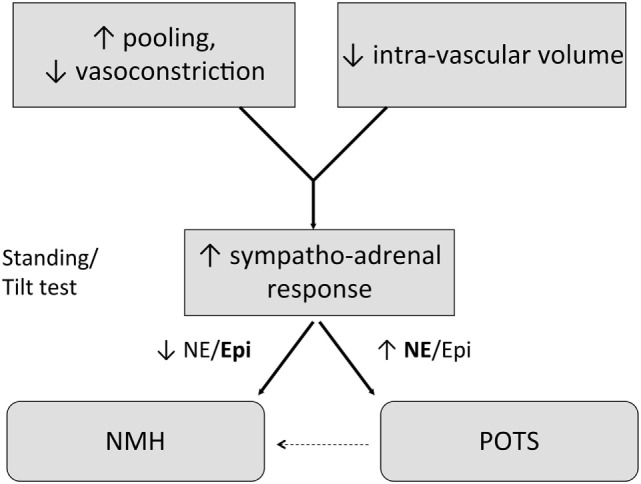
The three main pathophysiologic influences on orthostatic intolerance (OI) are shown in this Figure. Increased pooling of blood, or defective vasoconstriction in the lower half of the body, along with lower intravascular volume are each important, and can be present in the same individual. Upon assumption of an upright posture, exaggerated sympathetic nervous system and adrenal hormone responses lead to increased release of epinephrine (Epi) and norepinephrine (NE). It is postulated that the relative balance of NE to Epi is one factor in determining whether the phenotype of OI is POTS or neurally mediated hypotension (NMH). Some patients with POTS in the early phase of orthostatic testing go on to develop a classic NMH pattern later in the test.